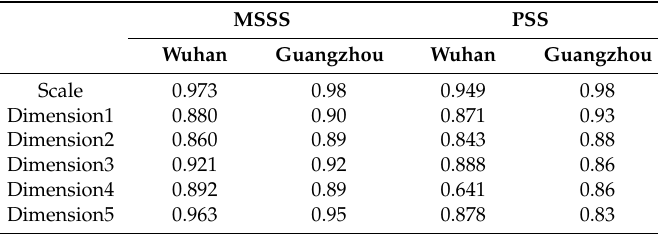
Table 1. Comparison of Cronbach’s alpha of the MSSS and PSS between Wuhan and Guangzhou.